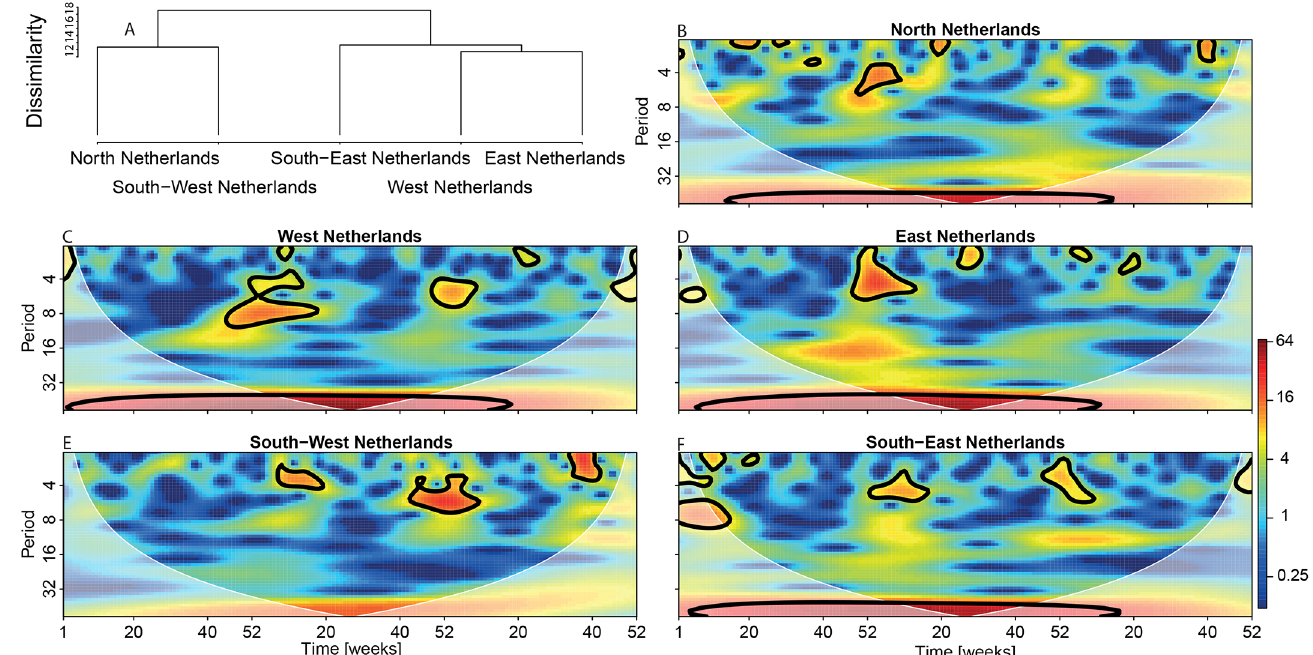
Fig 6. Wavelet power spectraof the age adjusted incidence for the five regions of the Netherlands. Color codes represent wavelet power and areas inside the black contour lines correspond to 95% confidenceregions where the power is higherthan the power of red noise with the same autocorrelation coefficient as the data. Transparent areas on the left and right hand sides of the plots represent the cone of influence,which is a region where edge effects are important. A cluster tree has been constructed (a) basedon the dissimilarity matrix of the wavelets power spectra.